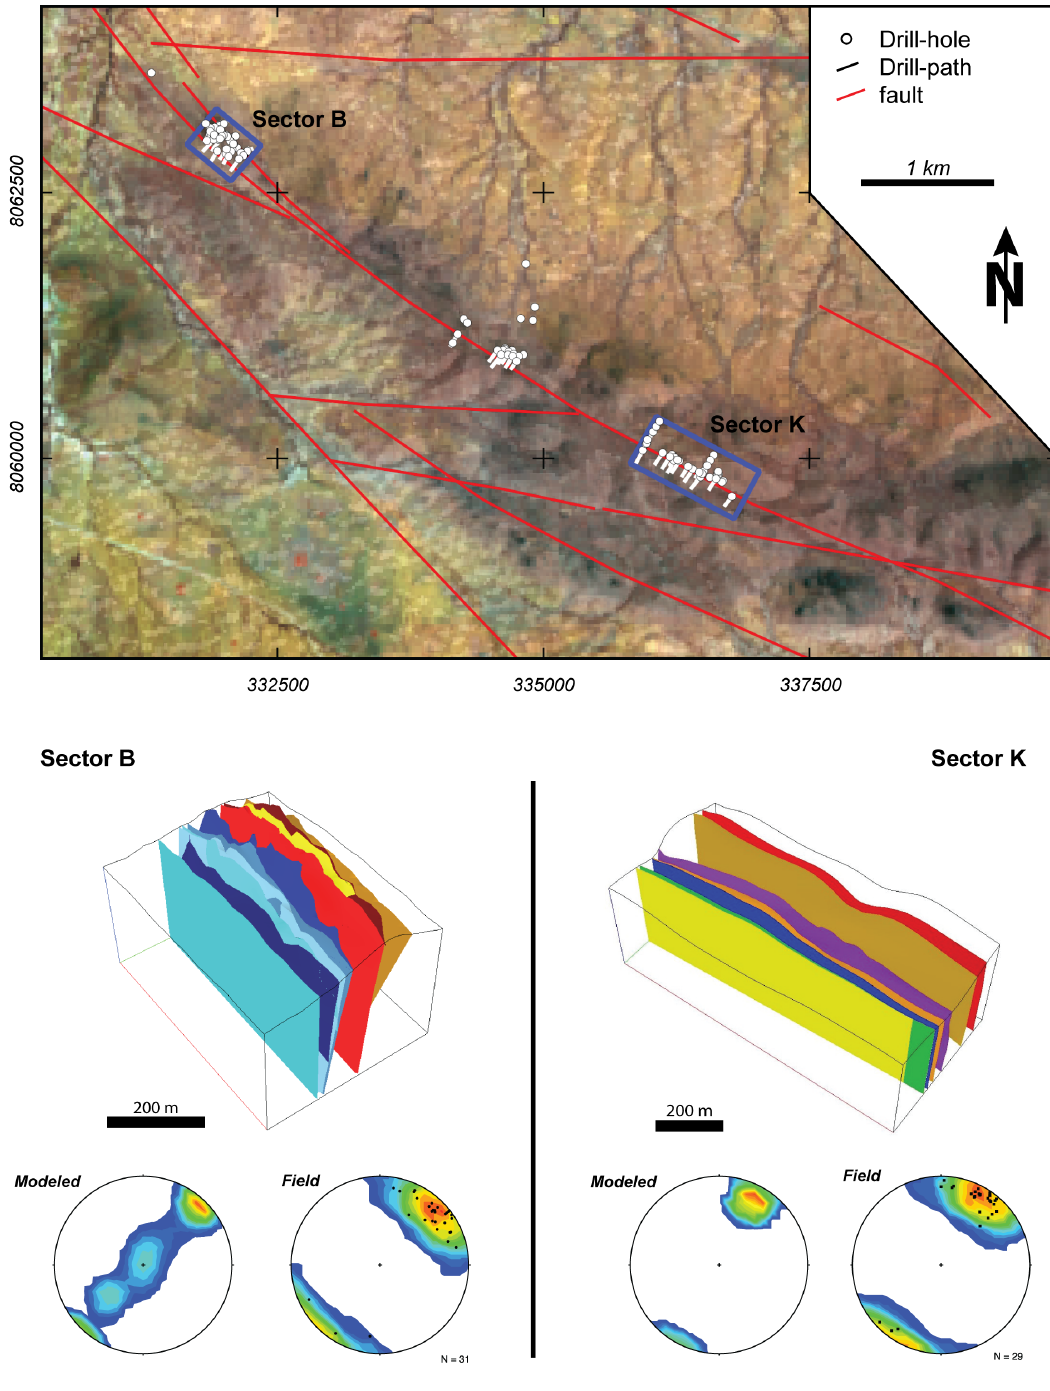
Figure 3. Landsat 8 False Color image (Band 7-4-3) from the carbonatite dyke of Epembe with drill locations and surface projection of the drill-paths, as well as the ones used in the models of Sector B and Sektor K. Below are the results of fault modeling of both sectors. Different colors are chosen for a better differentiation of the modeled faults. A comparison of stereograms of modeled and observed structural data shows the same trend (reference coordinate system: WGS 84/UTM zone 33